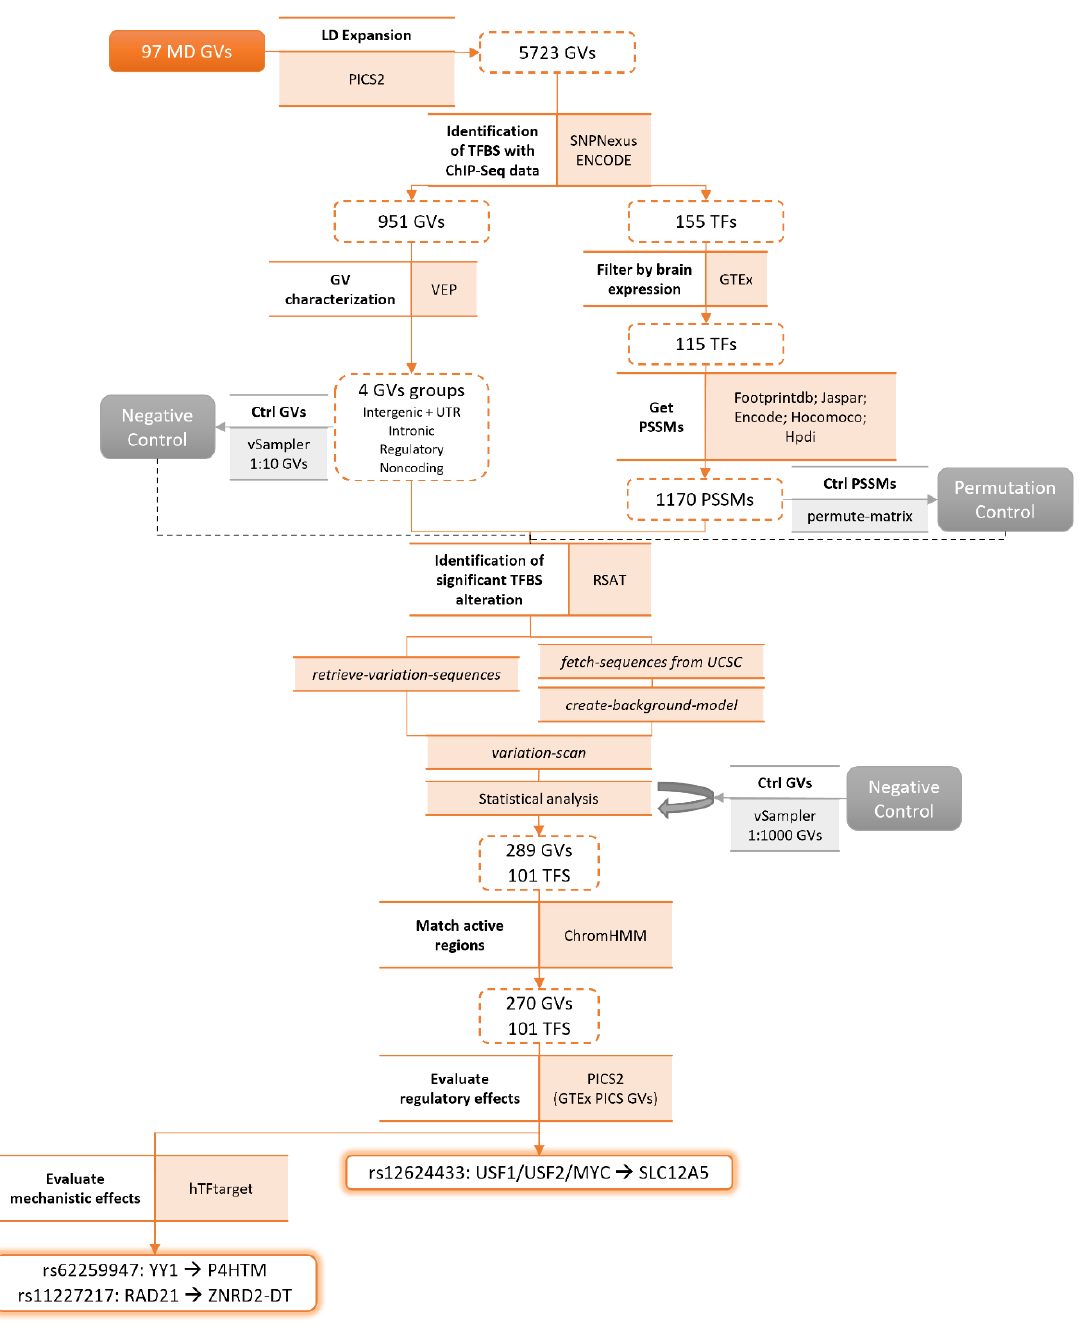
Scheme 2. Identification of altered TFBS using RSAT. Pipeline followed to identify GVs associated with MD that significantly alter TFBS. Methodologies are referred to in bold and along with them are the resources used. Highlighted in grey are the control datasets. TFBS: transcription factor bind-